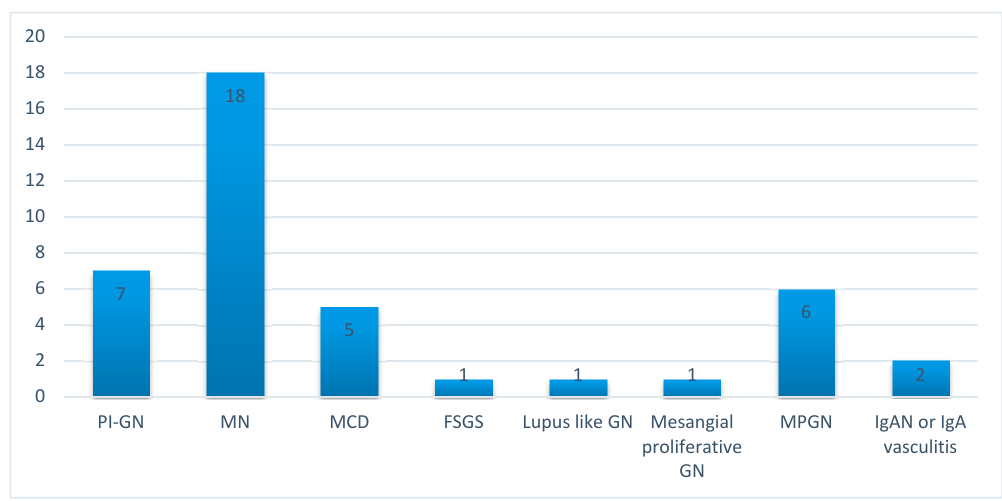
Figure 1. Distribution of histopathological diagnoses revealed by the kidney biopsy in the population of patients with GDAM.